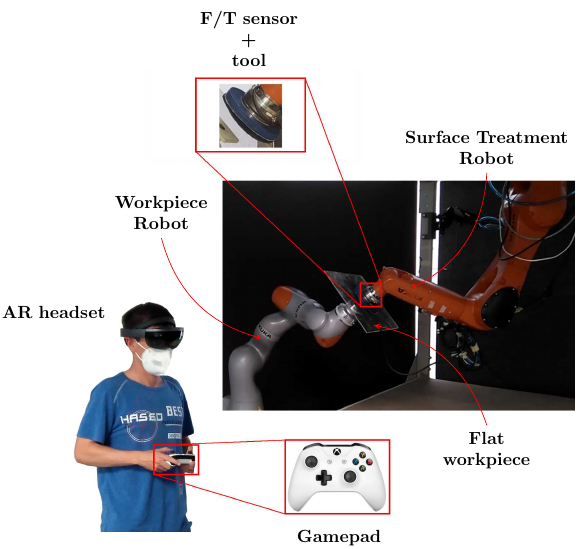
Figure 4. New setup used for the real